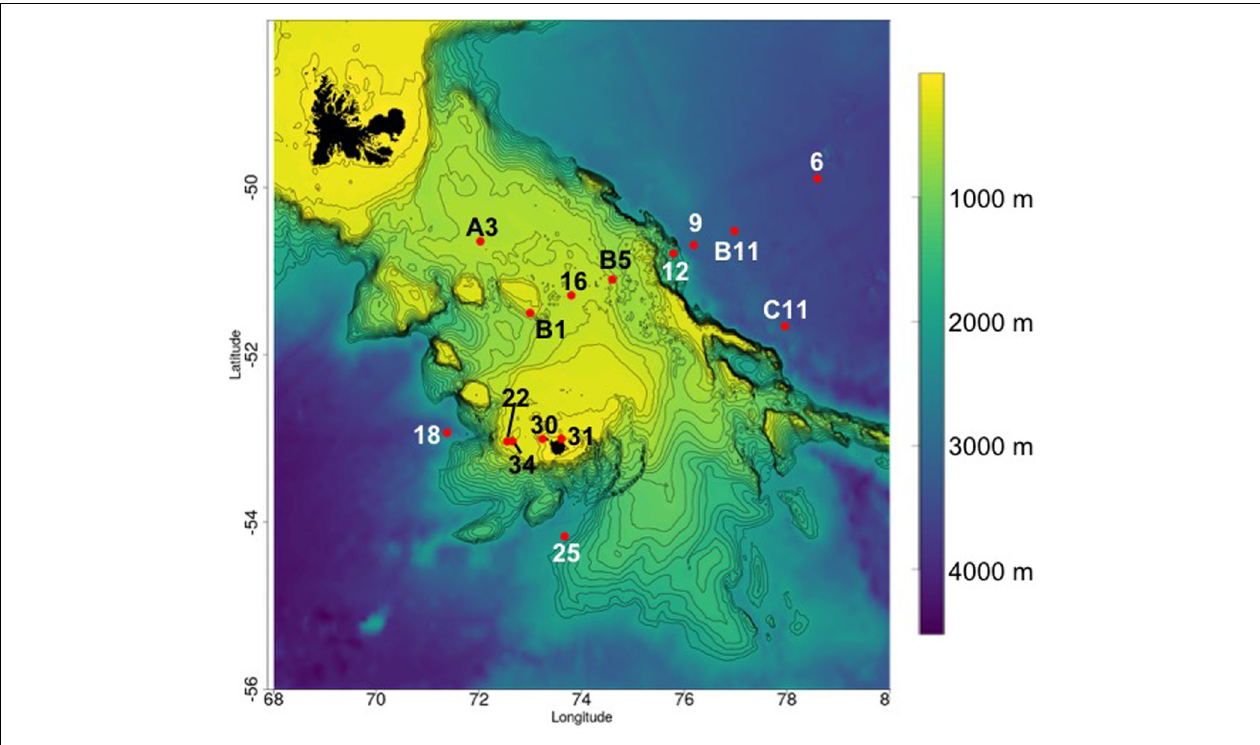
FIGURE 2 | High resolution bathymetry of the Kerguelen plateau (Beaman and O’Brien, 2011) and location of the stations sampled for Th isotopes during the HEOBI voyage. Different colors of the station numbers have been chosen for better visualization against the background. Included are stations from previous studies used in the discussion, including Stations B1, B5, B11, and C11 (Savoye et al., 2008) sampled during the KEOPS 1 voyage and Station A3 from KEOPS 2 (Bowie et al., 2015).